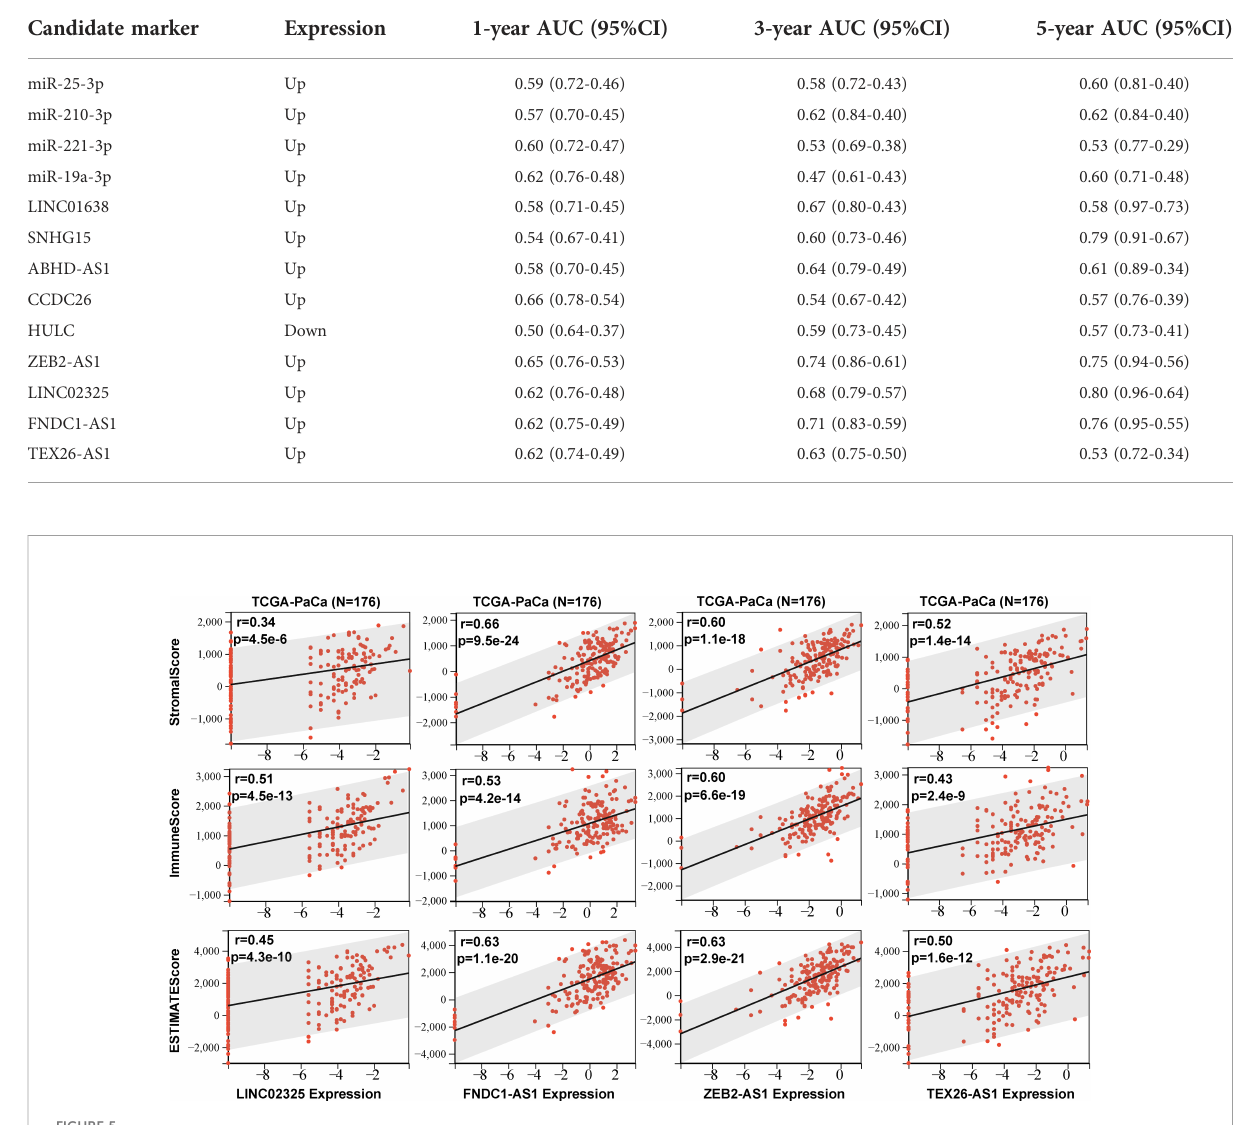
FIGURE 5 The stromal score, immune score and ESTIMATE score were obtained according to four IRlncRNAs (LINC02325. FNDC1-AS1. ZEB2-AS1. and TEX26-AS1) expression